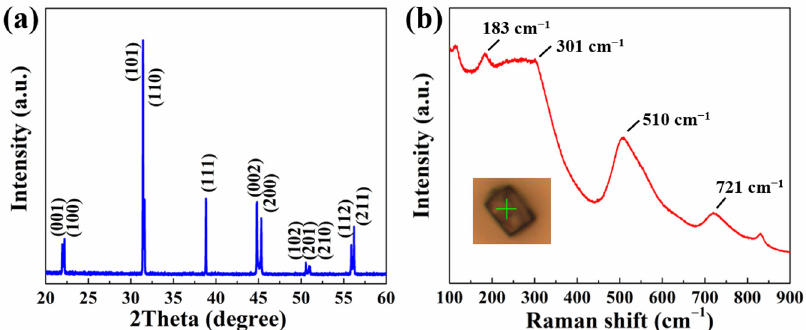
Figure 3. ( a ) XRD patterns and ( b ) the Raman spectra of BaTiO 3 plates synthesized at 950 ◦ C. The inset in ( b ) indicates the measuring region in a single template with the light spot marked by a green cross.